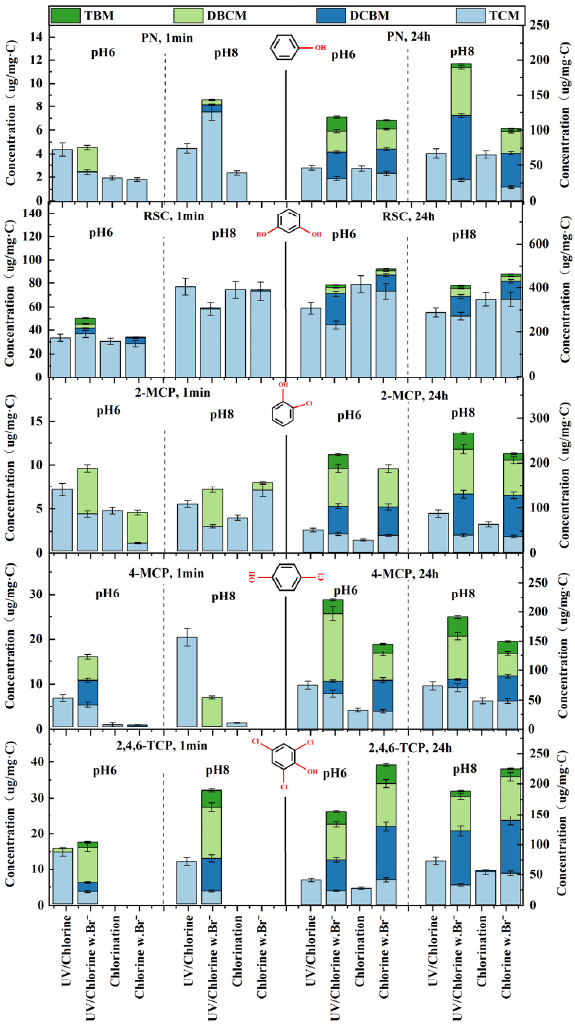
Figure 5. The formation of 4THM during the 1 min short-term oxidation and 24 h post-chlorination from five active benzene derivatives. Short-term oxidation conditions: Chlorine dose = 10 mg chlorine/L, pH = 6.0 or 8.0, [model benzene precursors] 0 = 3 mg-C/L, UV fluence rate = 10 mW/cm 2 , [bromide] 0 = 1 mg/L. Post-chlorination conditions: pH = 8.0, chlorination time = 24 h, chlorine residual = 1.0 ± 0.4 mg/L, dark, 22 ◦